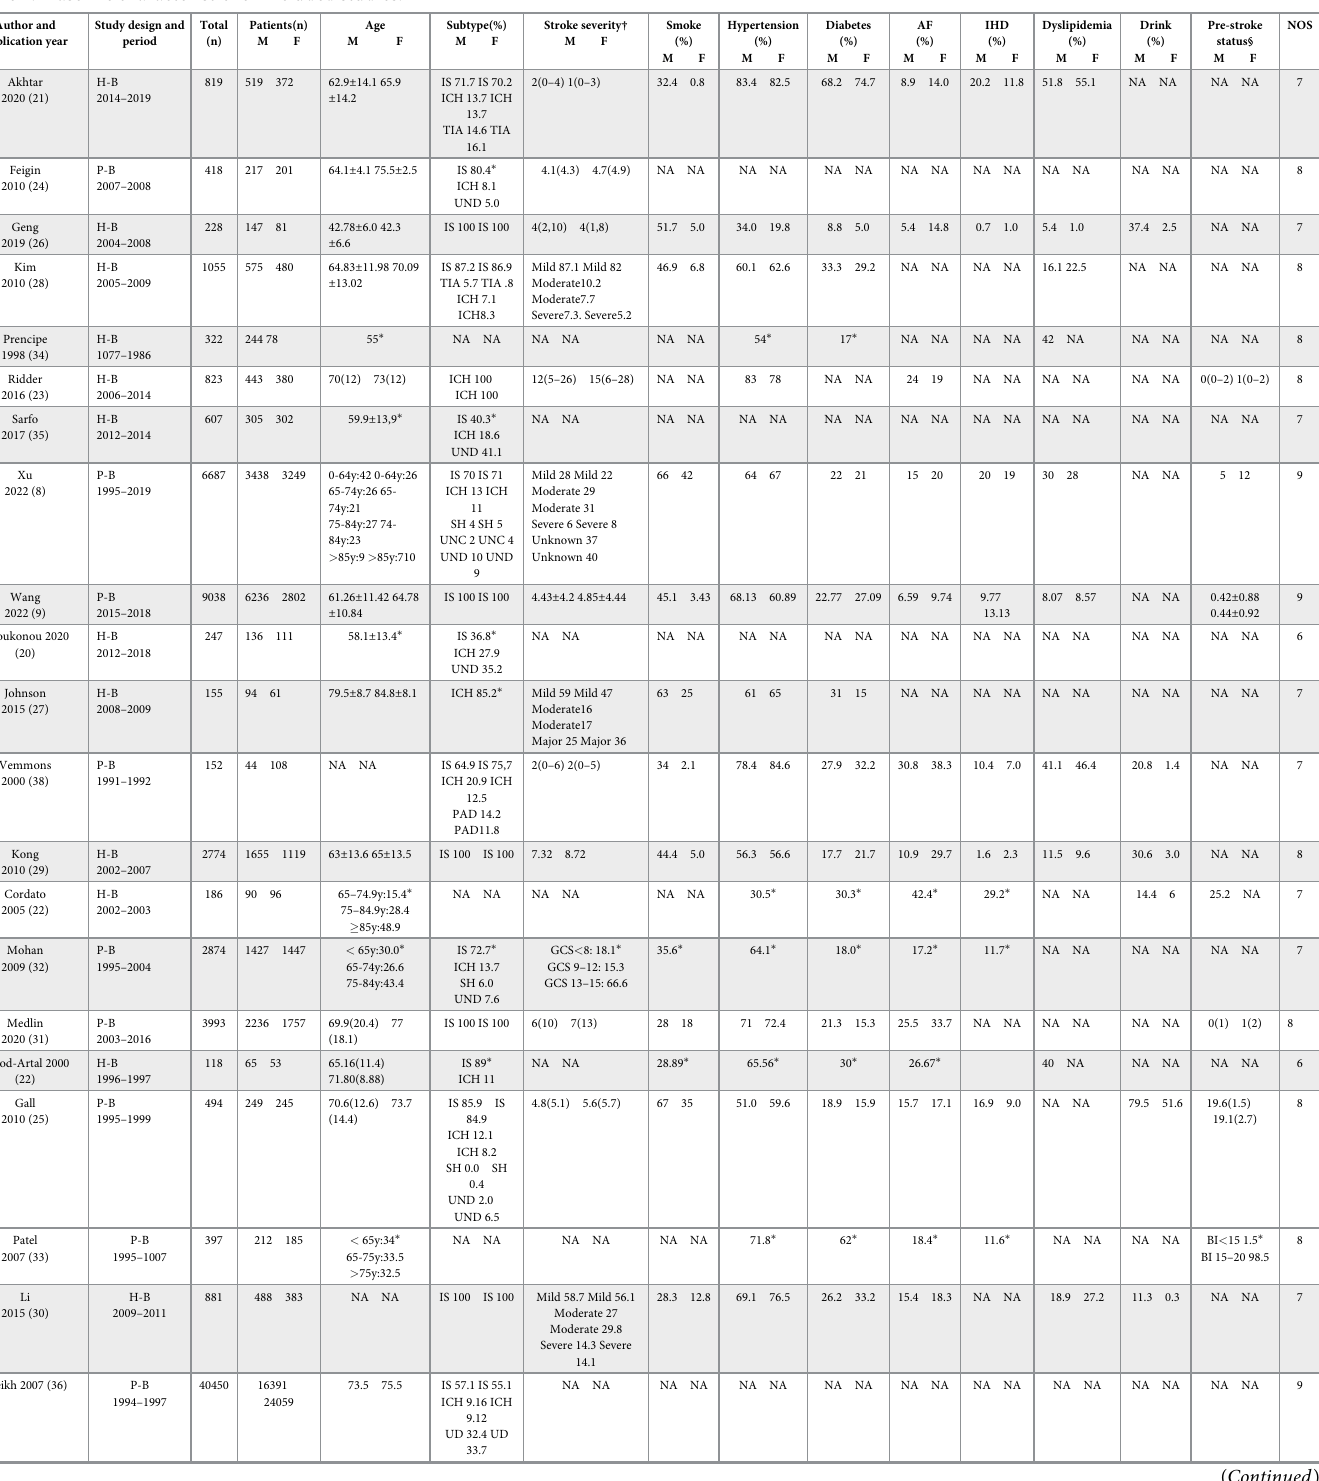
Table 1. Baseline characteristic for included